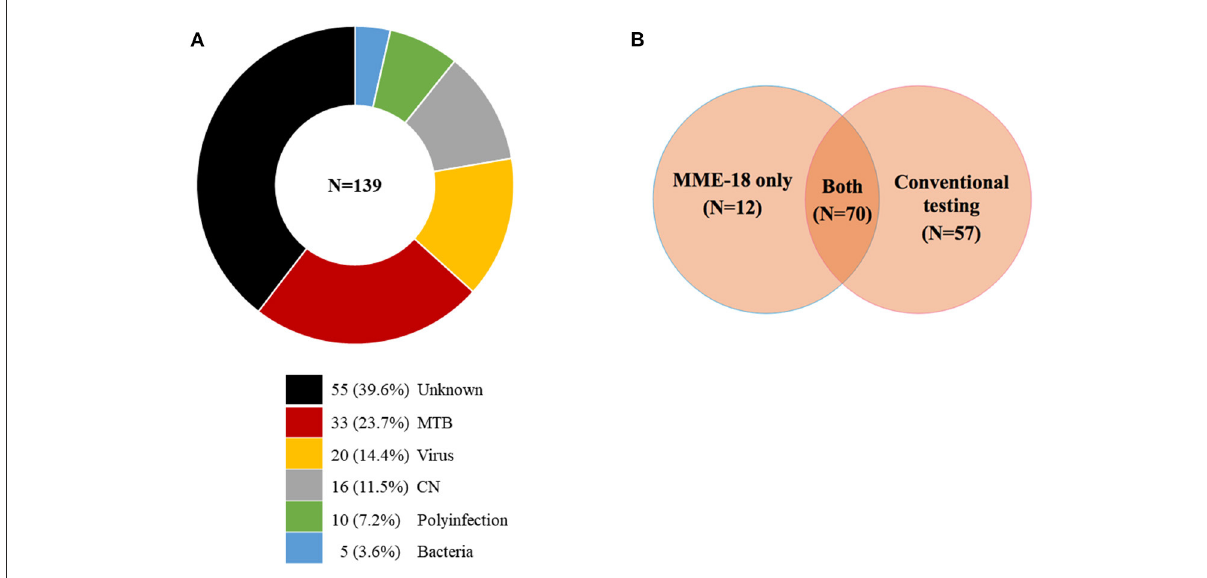
FIGURE2 (A,B) The infections diagnosed by MME-18, conventional testing, and clinical evaluation.